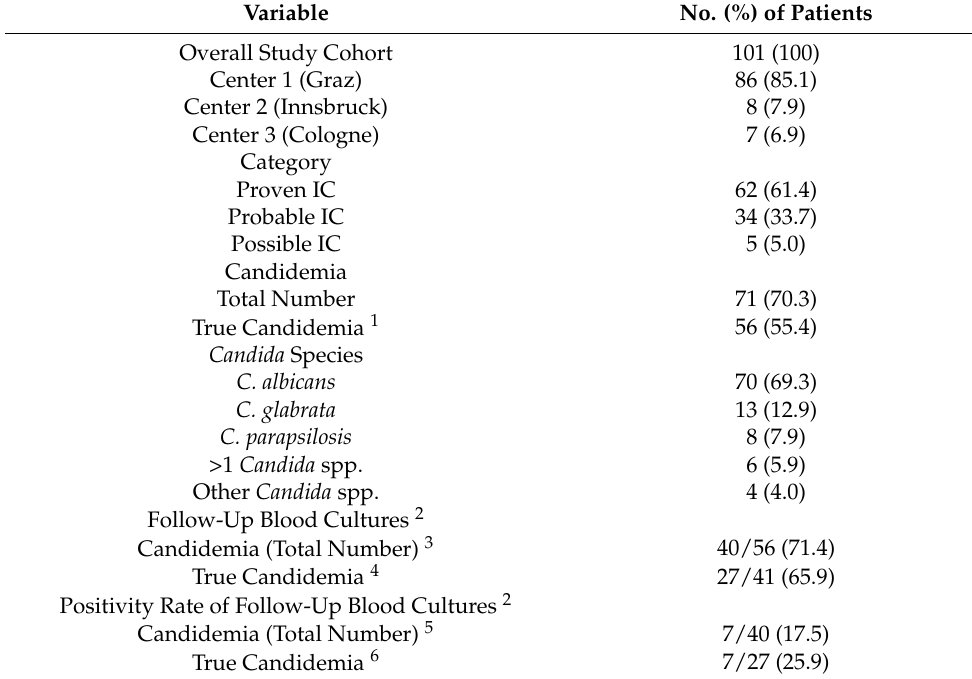
Table 2. Characteristics of patients with invasive